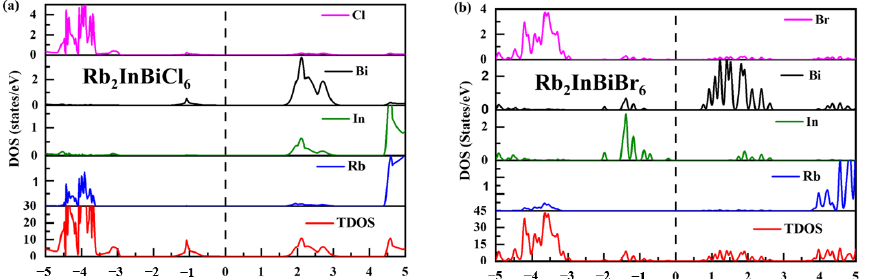
Figure 4. ( a , b ): Calculated electronic properties with ( a , b ) TDOS and PDOS for Rb 2 InBiX 6 (X = Cl, Br) compounds using mBJ approach.